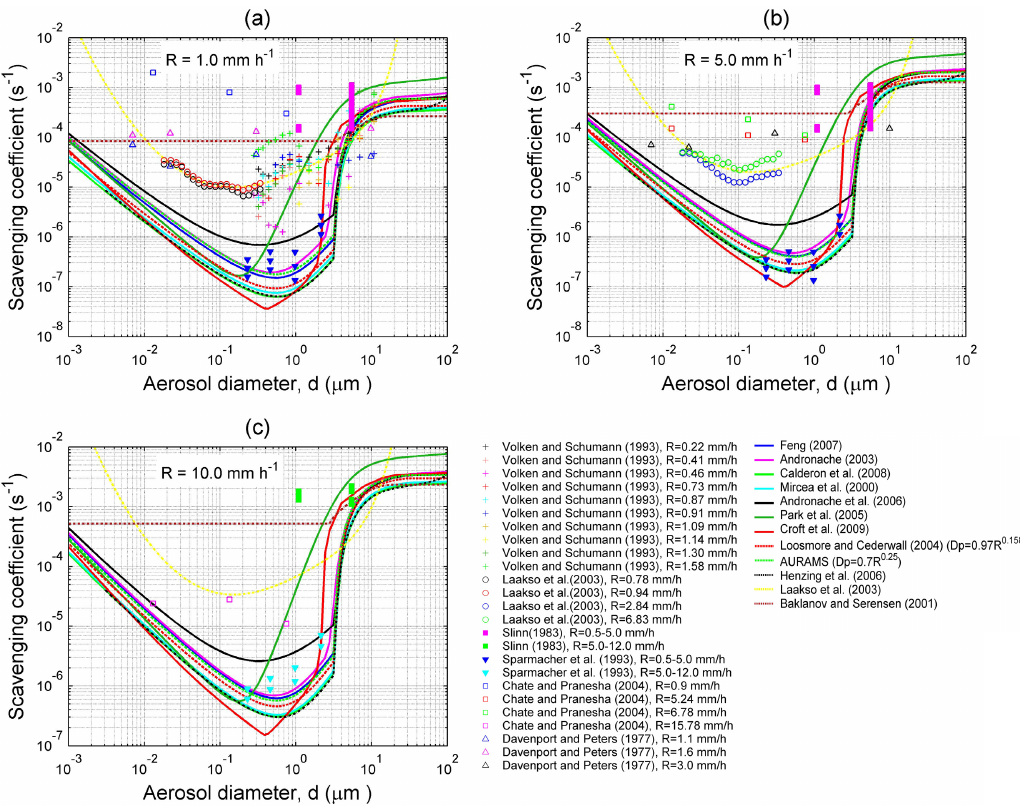
Fig. 8. Scavenging coefficients as a function of aerosol diameter calculated from ten theoretical and two empirical 3 parameterizations listed in Table 3 and taken from available measurements for rainfall intensities of (a) R =1mmh − 1 , (b) R =5mmh − 1 , and (c) R =10mmh − 1 . Note that the parameterization of Laakso et al. (2003) is only valid for particles with diameters between 0.01 and